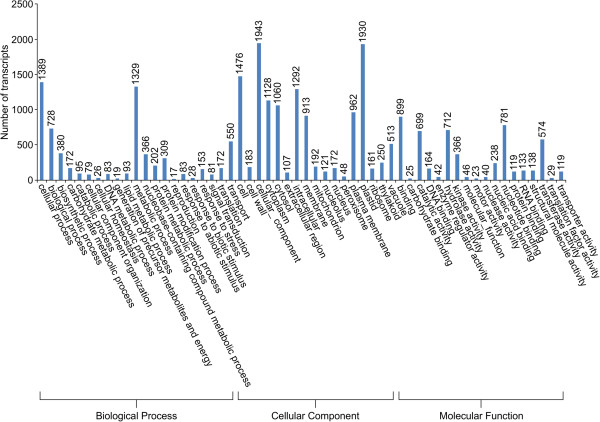
Functional classification of North American ginseng based on gene ontology categories. Gene ontology categories and classifications as identified by feeding the assembled transcriptome to the BLAST2GO web server.